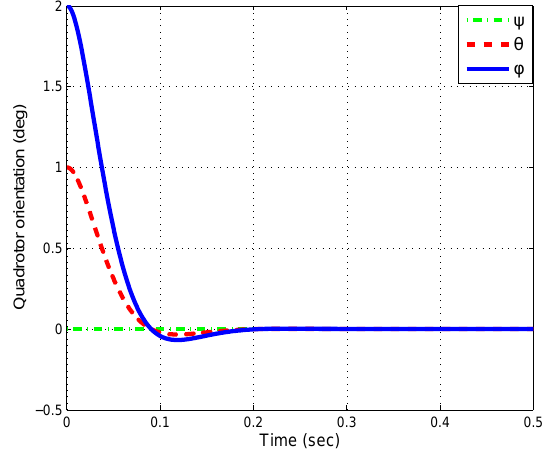
Figure 2. Quadrotor